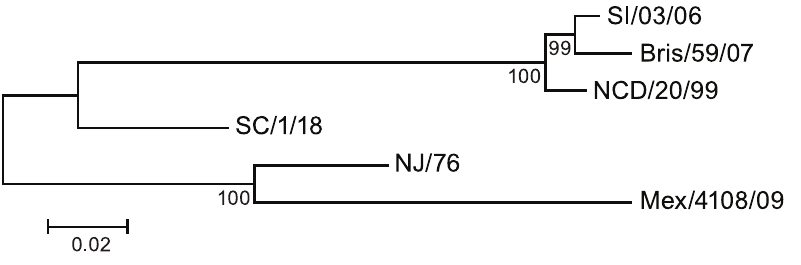
Figure 1. Genetic relationships among H1N1 HA. A phylogenetic tree was constructed for HA from six H1N1 influenza A strains, including recent seasonal strains, 2009 H1N1, and historic 1976 and 1918 influenza A strains. SI/03/06: A/Solomon Islands/3/2006; Bris/59/07: A/Brisbane/59/ 2007; NCD/20/99: A/New Caledonia/20/1999; SC/1/18: A/South Carolina/1/1918; NJ/76: A/New Jersey/1976; Mex/4108/09: A/Mexico/4108/2009.